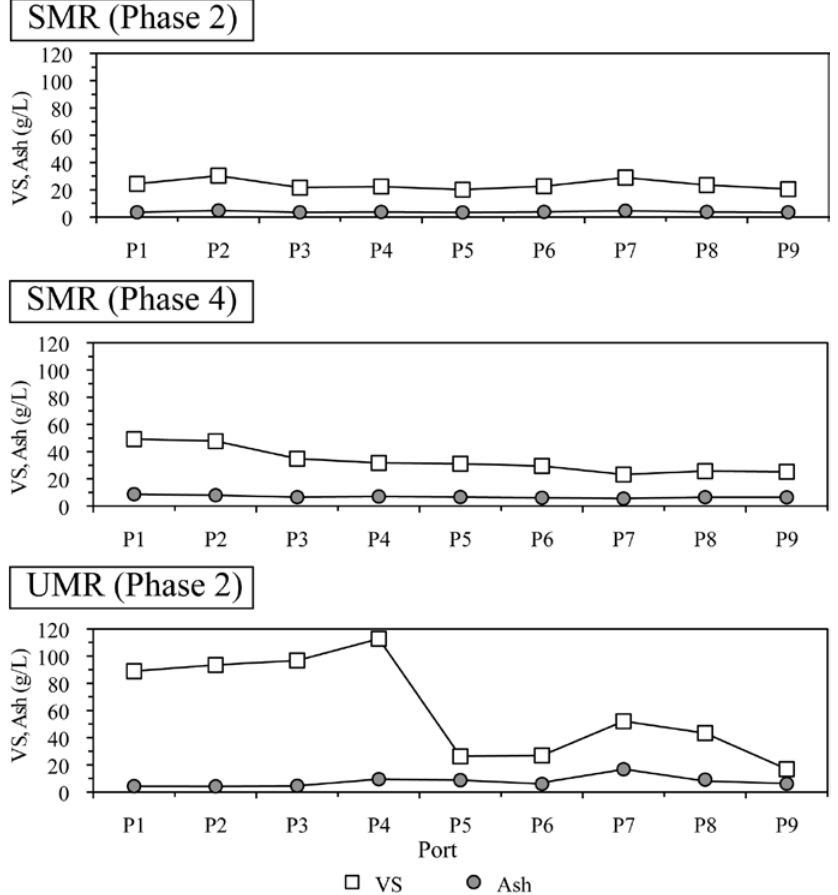
Figure 3. Variation patterns of VS and ash concentrations in the SMR and